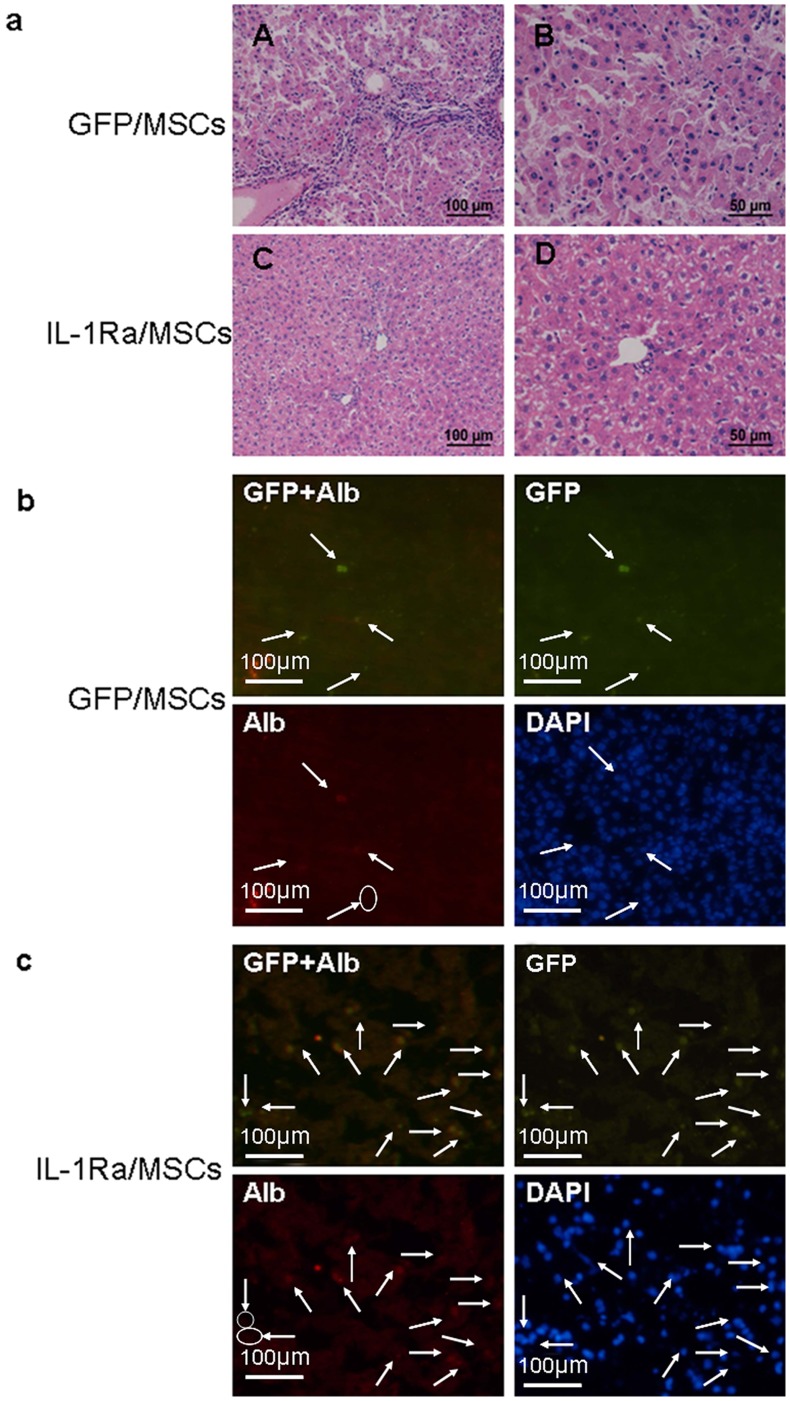
The incorporation of MSCs into injured livers and differentiation of hepatic MSCs in vivo.(a, b) Expression of albumin in GFP-labeled MSCs engrafted in liver tissues, detected by immunofluorescence histochemistry of tissues from IL-1Ra/MSC and GFP/MSC rats. A circle refers to no albumin expression in GFP-labeled MSCs in IL-1Ra/MSC and GFP/MSC rats. (c) Histological appearance of the liver 4 weeks after cell perfusion. Apparent hepatocyte degeneration and increased infiltration of mononuclear cells were detected in the green fluorescent protein/mesenchymal stem cell (GFP/MSC) rats (A, B), but not in the IL-1Ra/MSC rats (C, D). Original magnification ×200 (A, C) ×400 (B, D). Original magnification ×400. Alb, albumin; DAPI, 4′,6-diamidino-2-phenylindole.